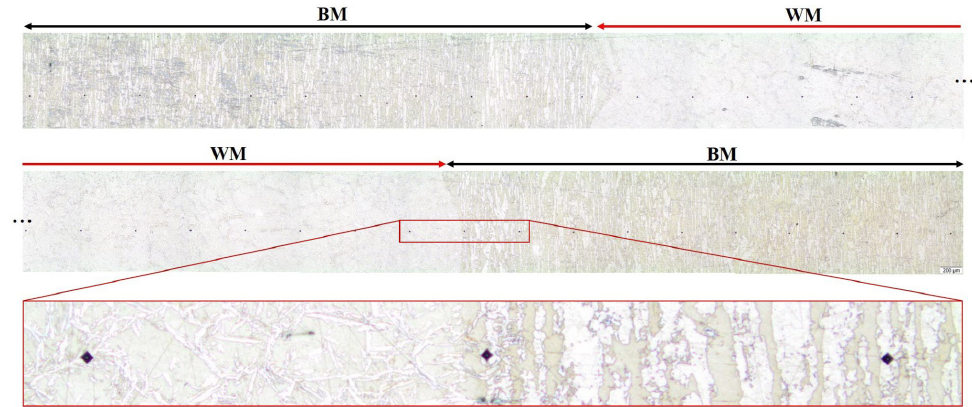
) carried out along the surface of the welded samples, perpendicular to the weld bead. Indentations Figure 5. Microhardness profile (HV 0.05 were performed every 0.5